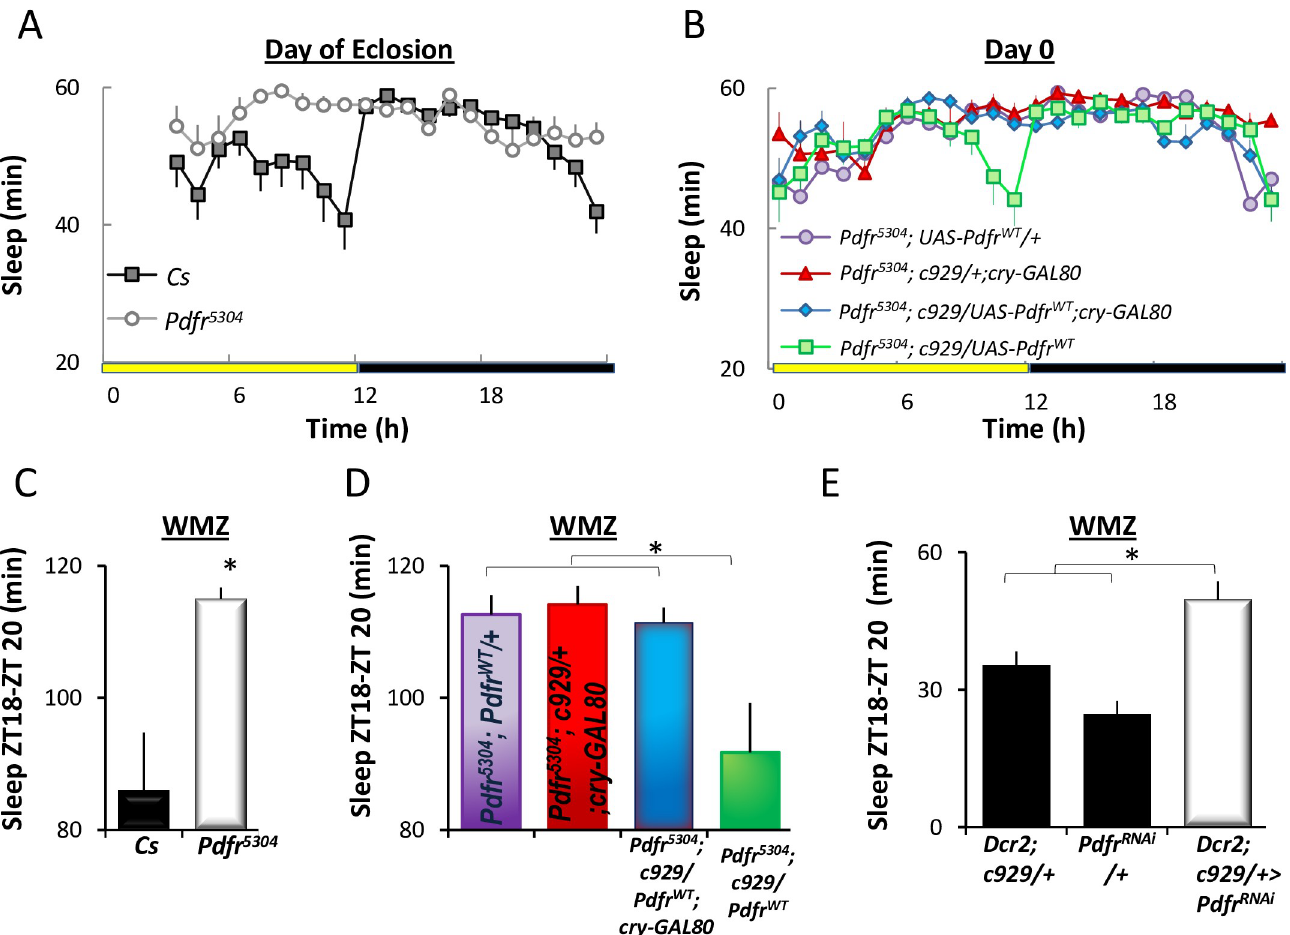
Fig 2. Expression of PDFR in l-LNvs regulates sleep in young flies. (A) Sleep traces of Pdfr 5504 mutants and Cs controls on day 0. (B) Sleep traces for Pdfr 5504 ; c929-GAL4; UAS-Pdfr (rescue, green), Pdfr 5504 ; UAS - Pdfr/+ , Pdfr 5504 ; c929-GAL4/+; Cry-Gal80/+ , and Pdfr 5504 ; c929-GAL4/ UAS-Pdfr ; Cry- Gal80 ( n = 26–31/ genotype). (C) Quantification of sleep during the WMZ of flies shown in (A). Cs flies sleep less during the WMZ than Pdfr 5504 mutants ( n = 26/genotype; t test, p < 0.05); (D) Quantification of sleep during the WMZ of flies shown in (B). Pdfr 5504 ; c929-GAL4; UAS-Pdfr sleep less than parental controls; ANOVA F [3,109] = 6.33, p = 5.4 E-4 ; n = 22–31. (E) Sleep is increased in Dcr2; c929-GAL4 / UAS-Pdfr RNAi flies on day 0 compared to Dcr2; c929-GAL4 / + and UAS-Pdfr/+ parental controls (ANOVA; F [2,279] = 12.00, p = 1.04 E-5 ; n = 26–28). Data underlying this figure can be found in S2 Data. l-LNv, large ventral lateral neuron; PDFR, pigment dispersing factor receptor; WMZ, wake maintenance